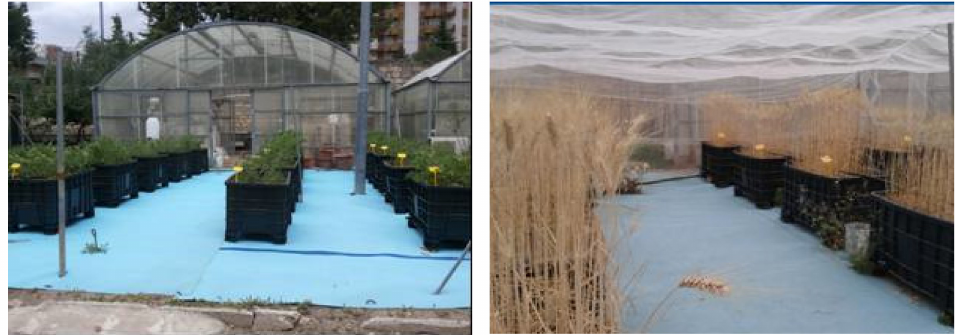
Figure 4. Experimental tests relating to the cultivation of industrial tomatoes and durum wheat.